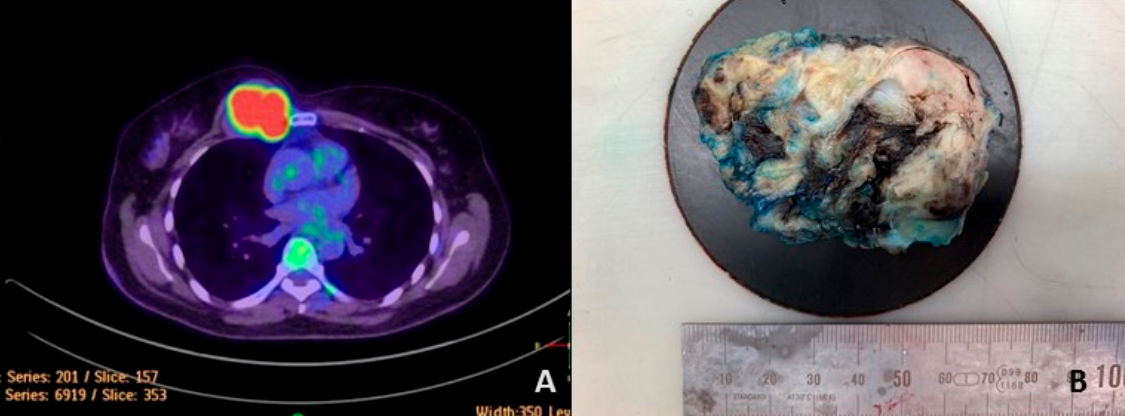
Figure 1. A positron emission tomography-computed tomography (PET-CT) image of the patient showed a right parasternal hypermetabolic rate tumor with thoracic wall and coastal invasion ( A ). The tumor shows a fleshy and greyish-white cut surface with a hemorrhage focus ( B ).